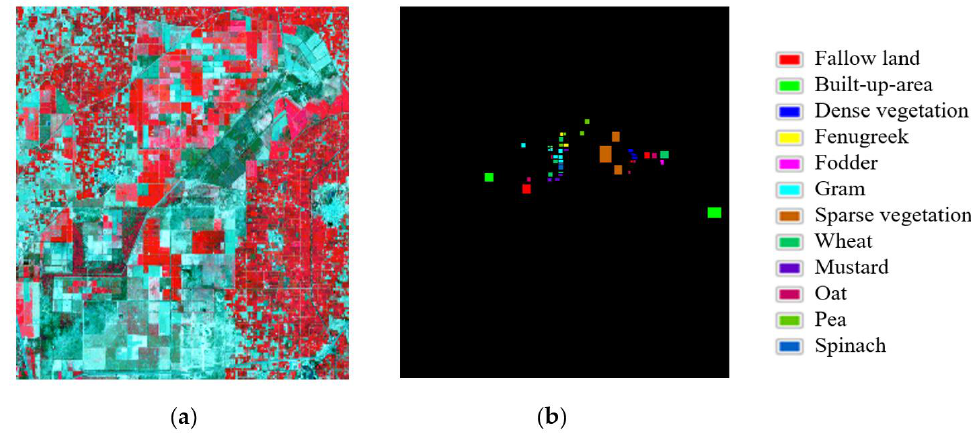
Figure 1. ( a ) False Color Composite (FCC) image and ( b ) Ground Truth image of the study